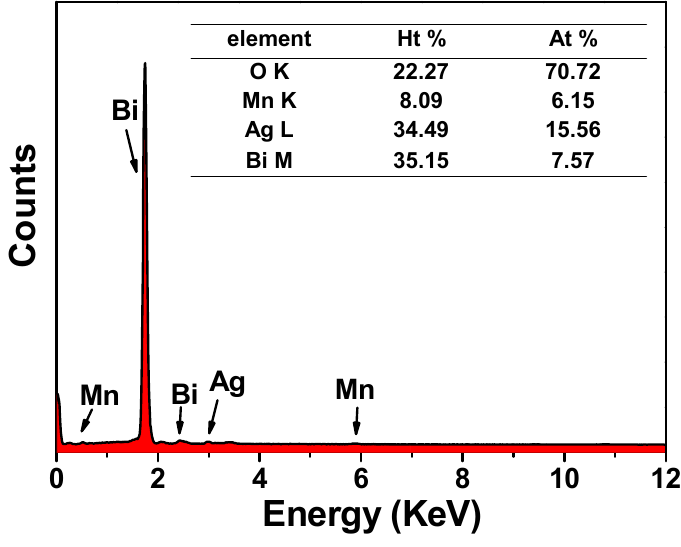
Figure 6. Energy dispersive spectrometry (EDS) analysis of Ag 4 Bi 2 O 5 with 60% Mn.